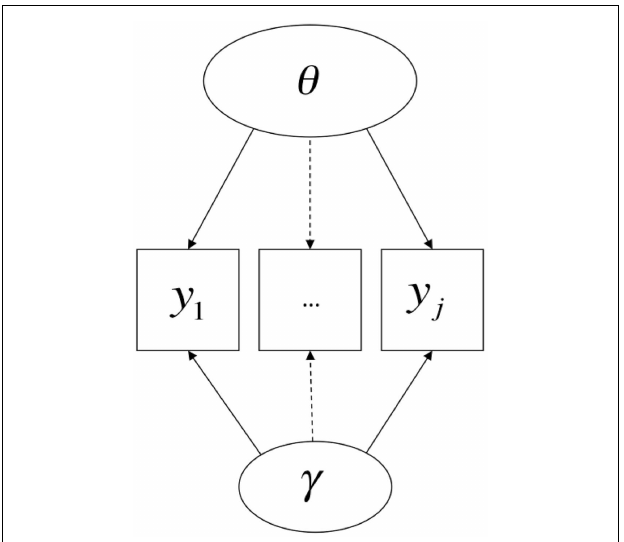
FIGURE 5 | Method confounded with